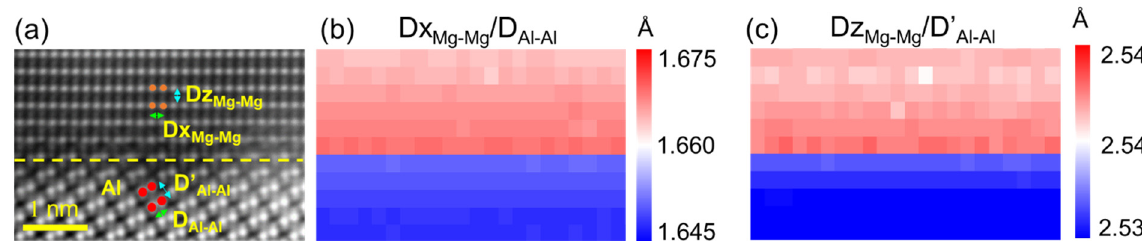
Figure 6. ( a ) HAADF image containing MgO/c-Al 2 O 3 interface, ( b , c ) atomic bond length maps of Dx Mg-Mg /D Al-Al , and Dz Mg-Mg /D’ Al-Al , respectively.